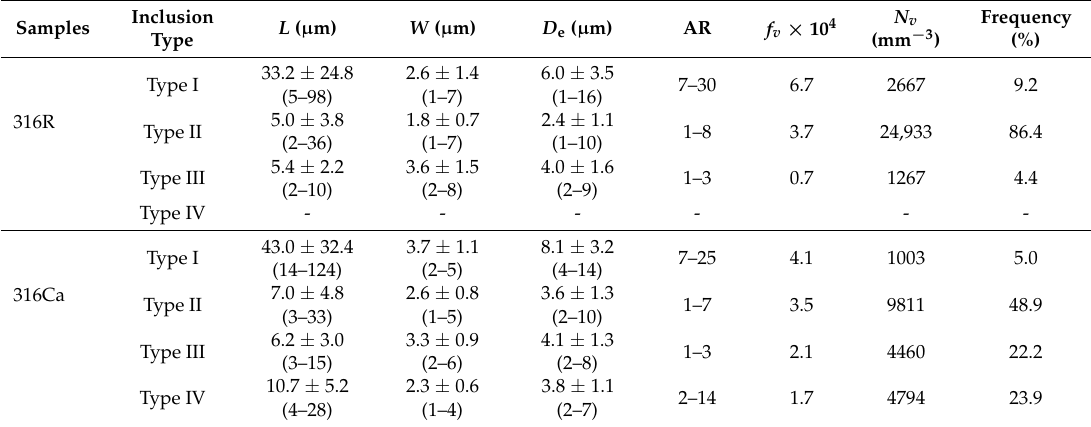
Table 4. Distribution and information about different types of inclusions found in 316Ca